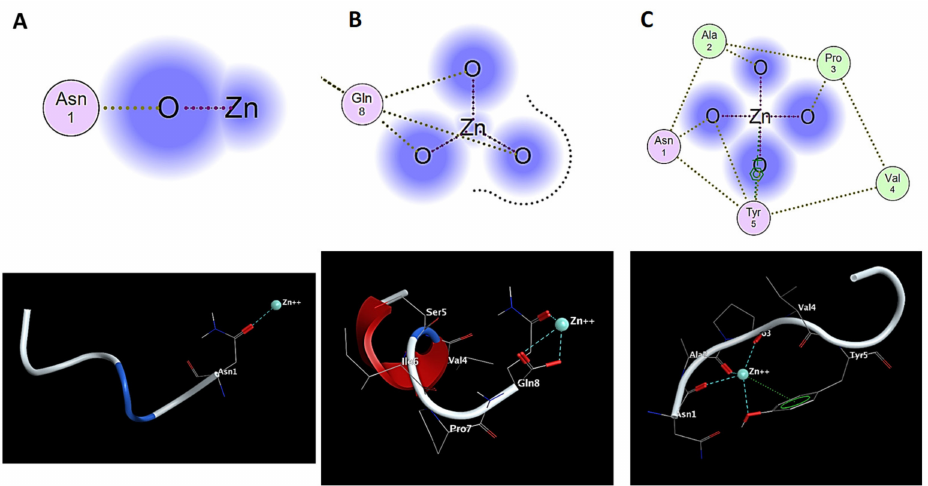
Figure 10. Flexible alignment of Zn 2+ interaction, with NAP ( A , B ) and NAPY ( C ), performed with Molecular Operating Environment